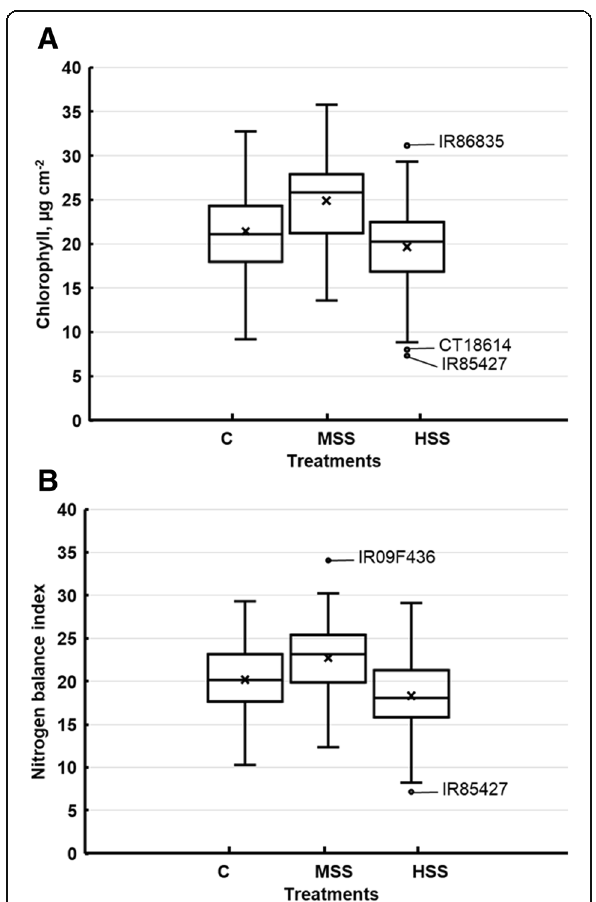
Fig. 3 Box and whisker plots for physiological traits showing natural variation and the effect of different salinity treatments on the average ( a ) chlorophyll content, μ g cm − 2 , and ( b ) nitrogen balance index (unitless). The genotypes below the first quartile or above the third quartile are representing outliers in individual traits, are also